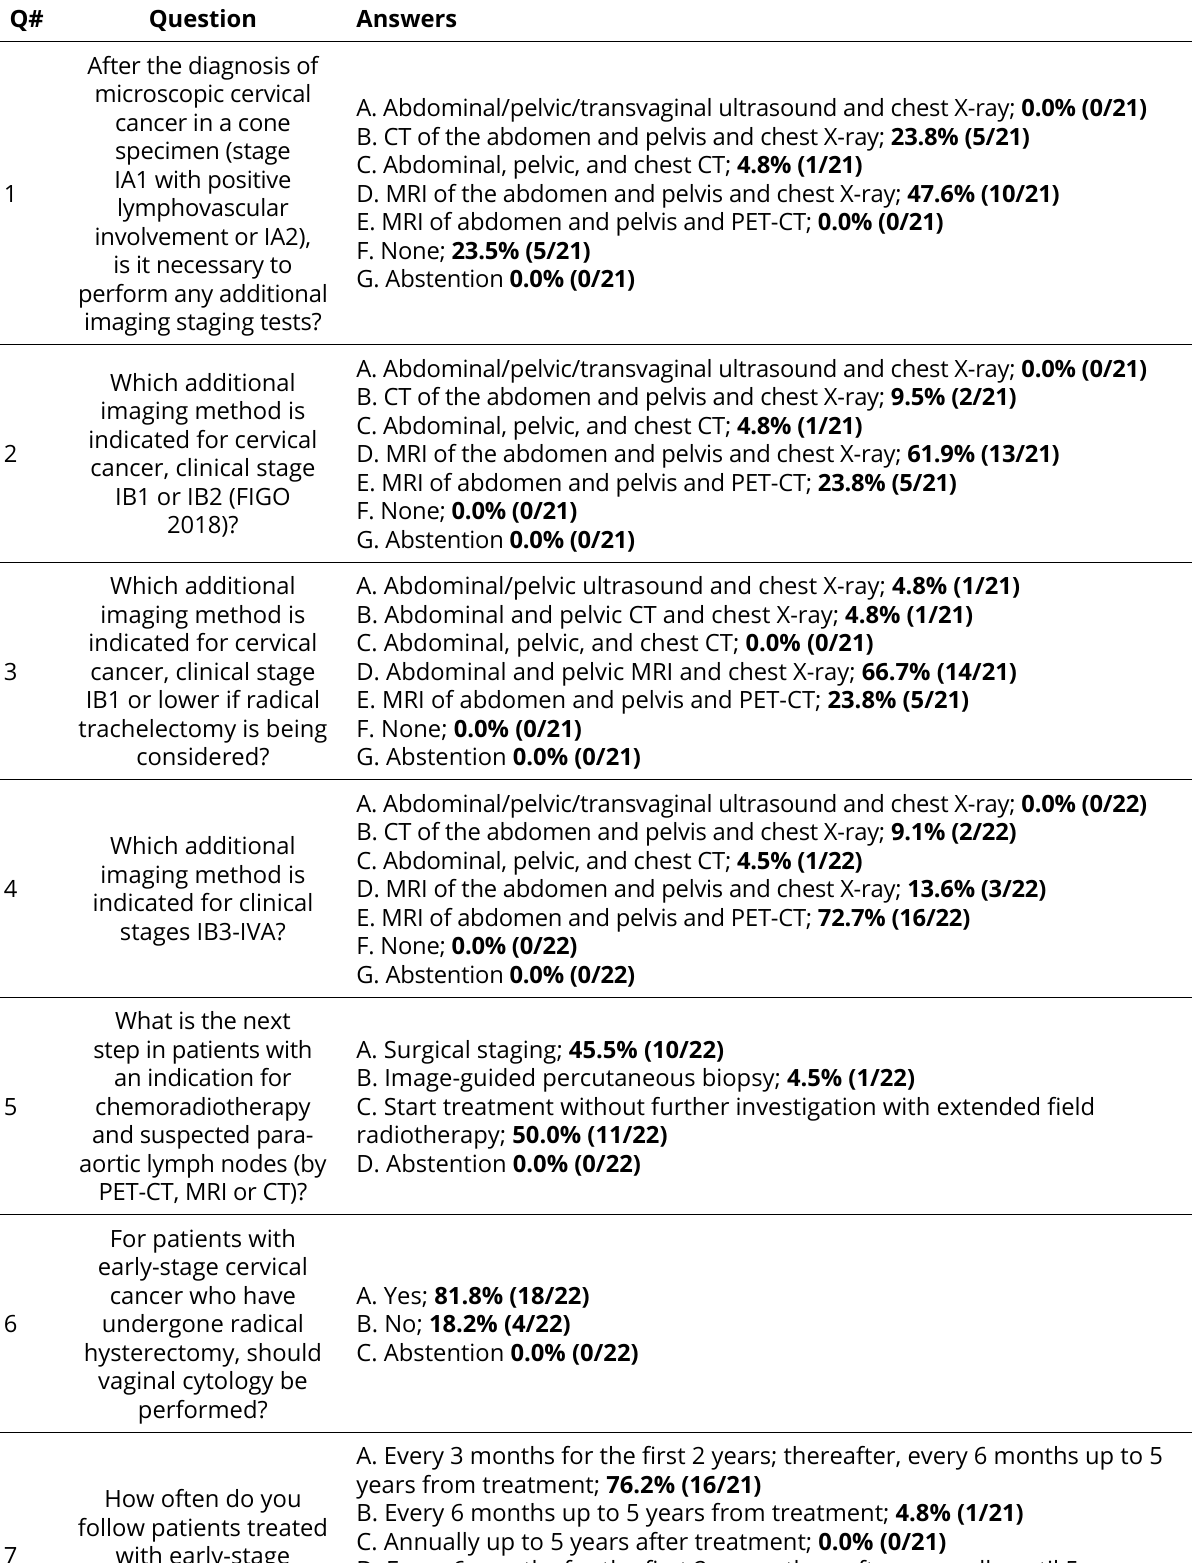
Consensus panel questions and